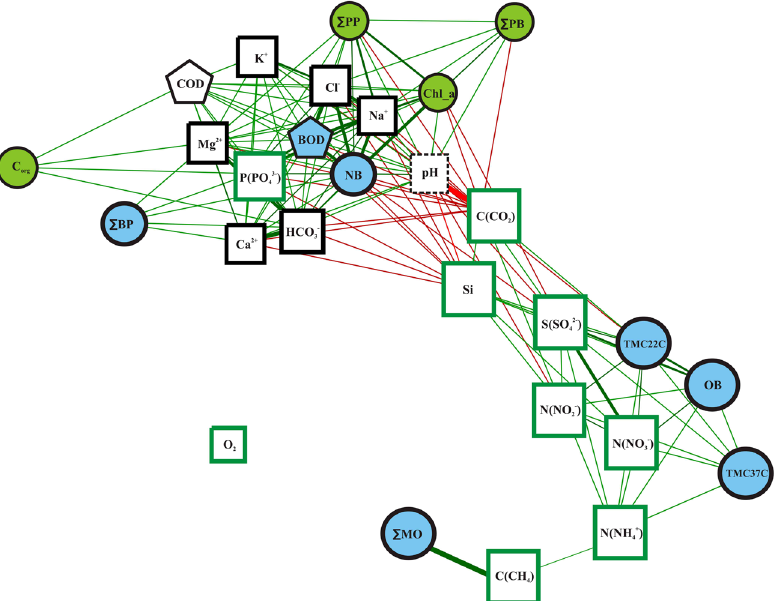
Figure 4. The network of correlations between all measured parameters (both biological and hydrochemical). Blue shapes mark the parameters related to the bacterial activity, green circles mark the parameters related to phytoplankton activity, black squares — mineral ion concentrations, green squares — concentrations of biogenic elements, pentagons mark the rate of biogenic and chemical oxidation of organic matter. Green edges mean significant positive correlations, red edges mean significant negative